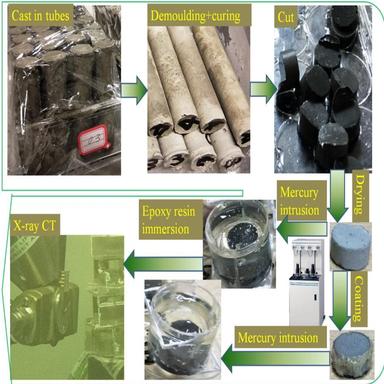
Sequences of sample preparation with/without surface conformance control for MIP and X-CT tests.